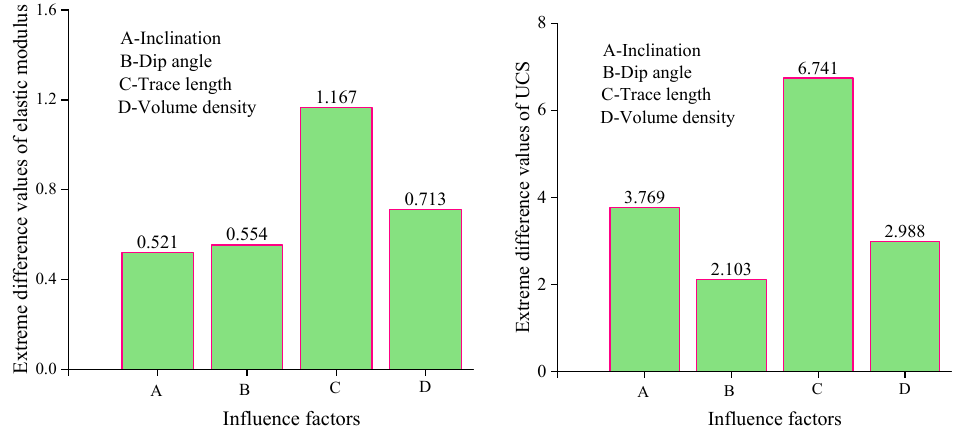
Figure 6. Extreme difference values of the elastic modulus and UCS under various influencing factors.